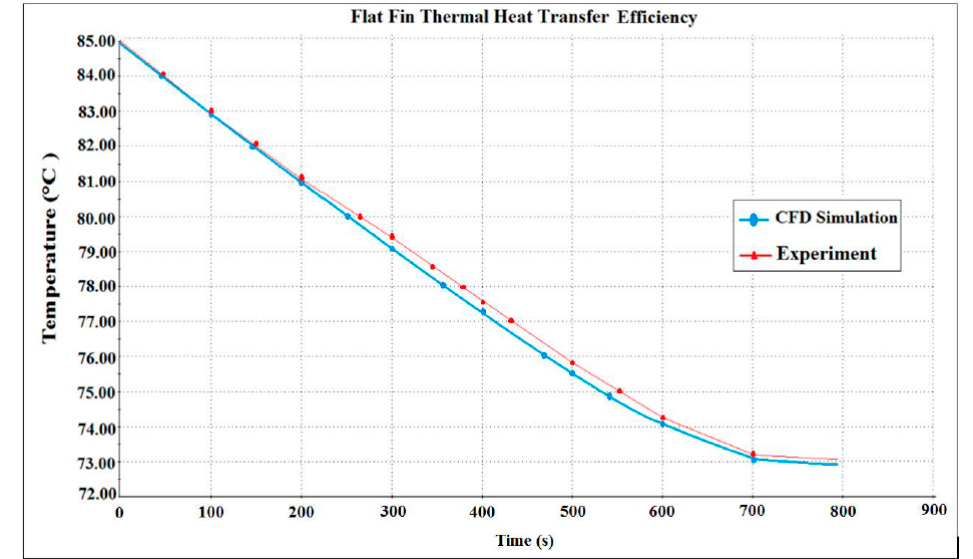
Figure 20. Changes of heat transfer efficiency over time.